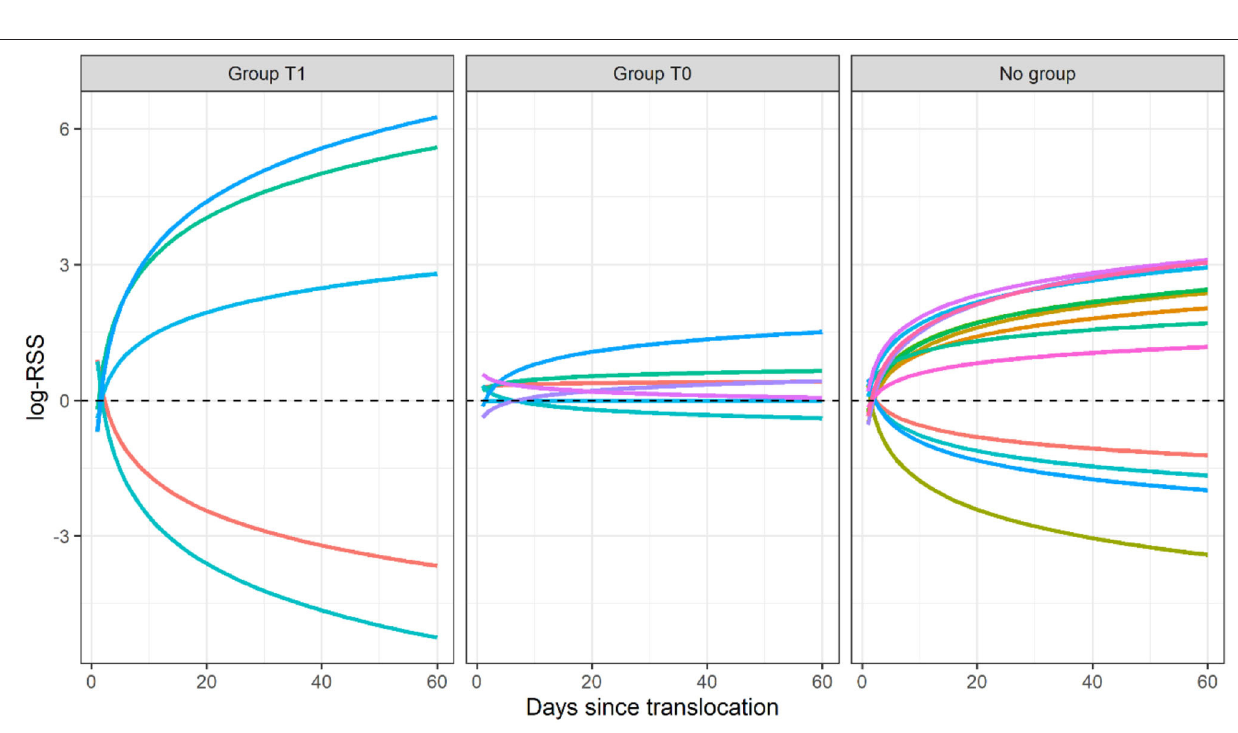
Frontiers in Conservation Science |